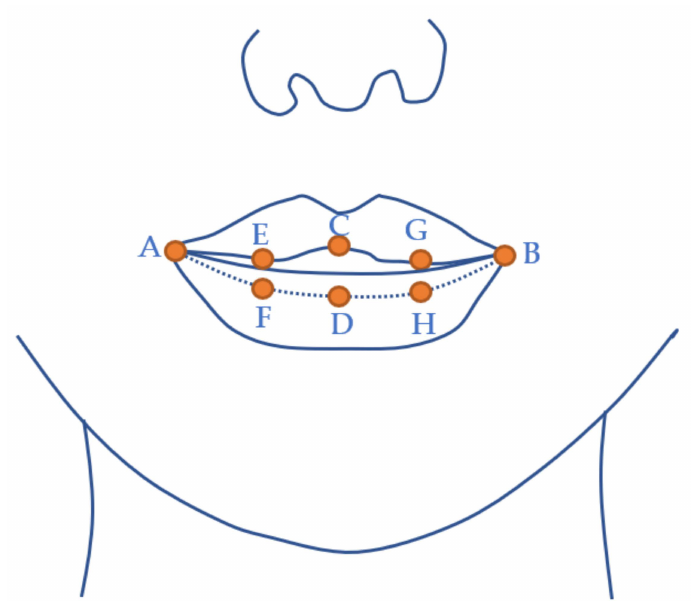
Figure 5. Keypoints labelled on the lip video. Dotted line indicates mucosal border on the lower lip that makes contact with the upper lip when the mouth is closed. A and B—commissures; C and D—centre of the upper and lower lip, respectively (defined by philtrum midpoint and not necessarily equidistant from A and B); E—equidistant from A and C; F—equidistant from A and D; G—equidistant from B and C; H—equidistant from B and